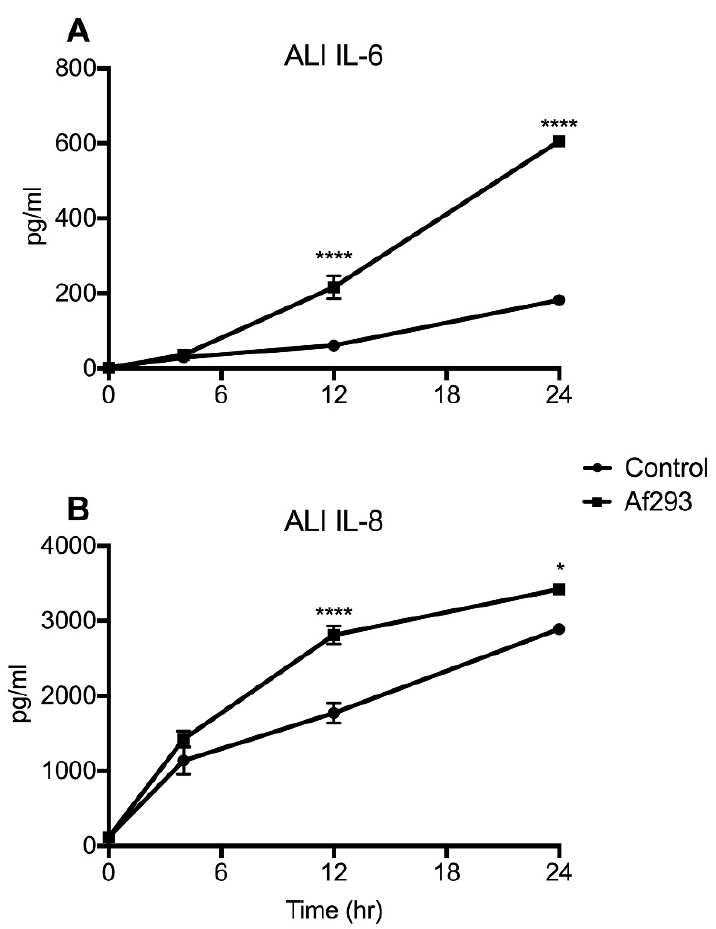
Figure 3. Primary human nasal epithelial cells grown at air–liquid interface show progressive increase in cytokine levels following exposure to A. fumigatus . Exposure to A. fumigatus conidia caused a significant upregulation of ( A ) IL-6 and ( B ) IL-8 protein levels at 12 h and 24 h, relative to controls. Data represent mean +/ − SEM; one-way ANOVA with Bonferroni multiple comparison test. **** p < 0.0001, * p < 0.05 compared with control.